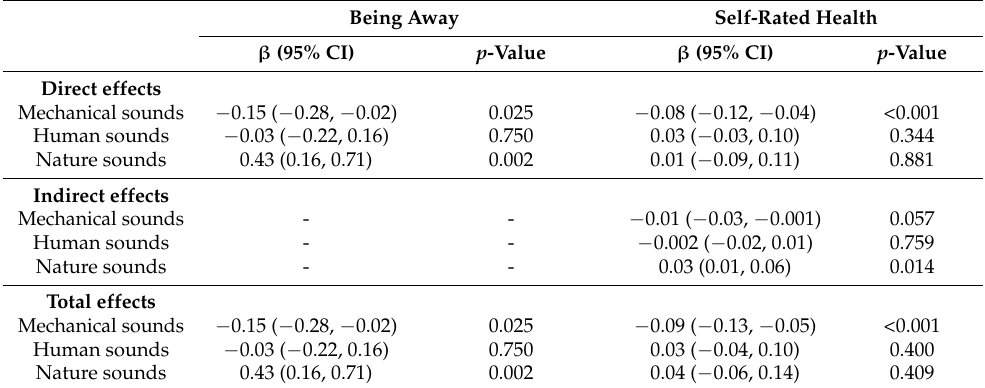
Table 7. Associations between perceived sounds, “being away” and self-rated health in the structural equation model.